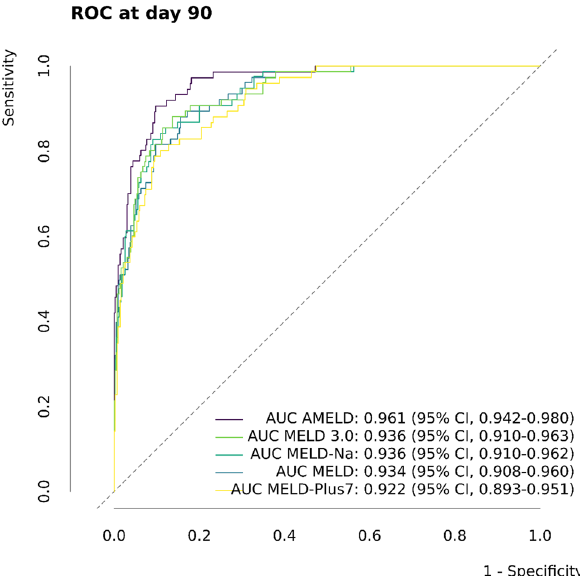
Figure 2: Receiver operating characteristic (ROC) curve. Area under the time-dependent ROC curve (AUC) based on the nonparametric inverse probability of censoring weighting estimate (IPCW) for AMELD, MELD, MELD-Na, MELD 3.0, and MELD-Plus7, as described in